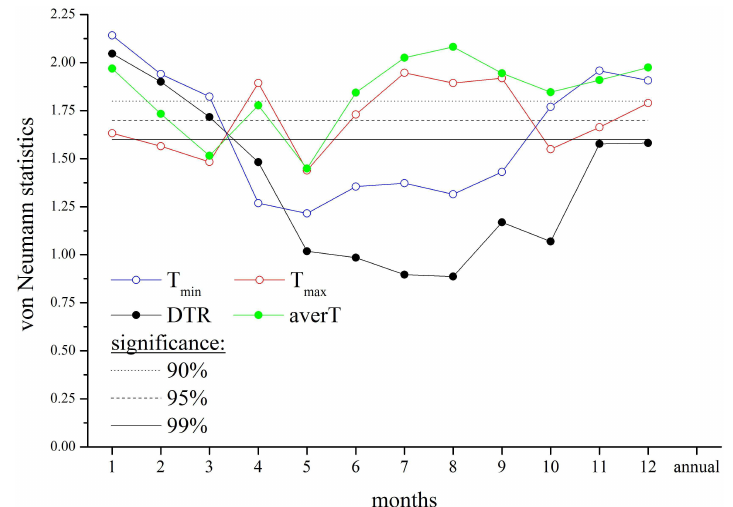
Figure 4. Porto: von Neumann ratio statistics for monthly series of T min , T max , DTR and T aver . Black straight lines show probability levels.